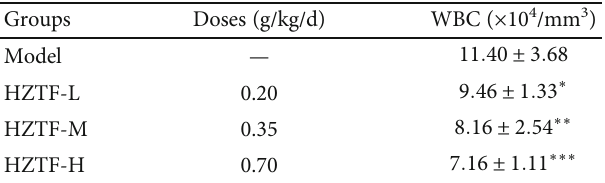
Table 5: E ff ects of HZsTF on the time to respond in the hot-plate test in mice ( n = 10 ).